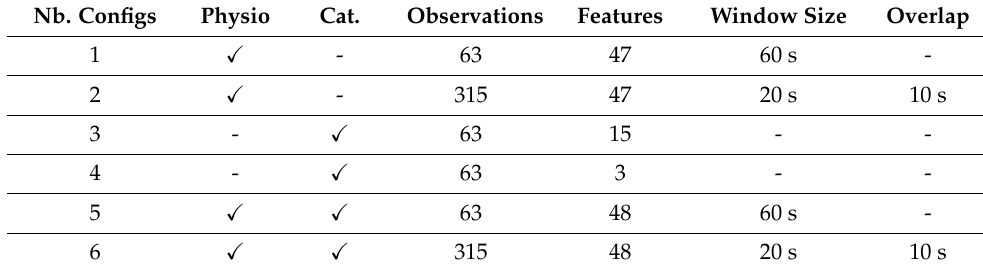
Table 7. Characteristics of each configuration.